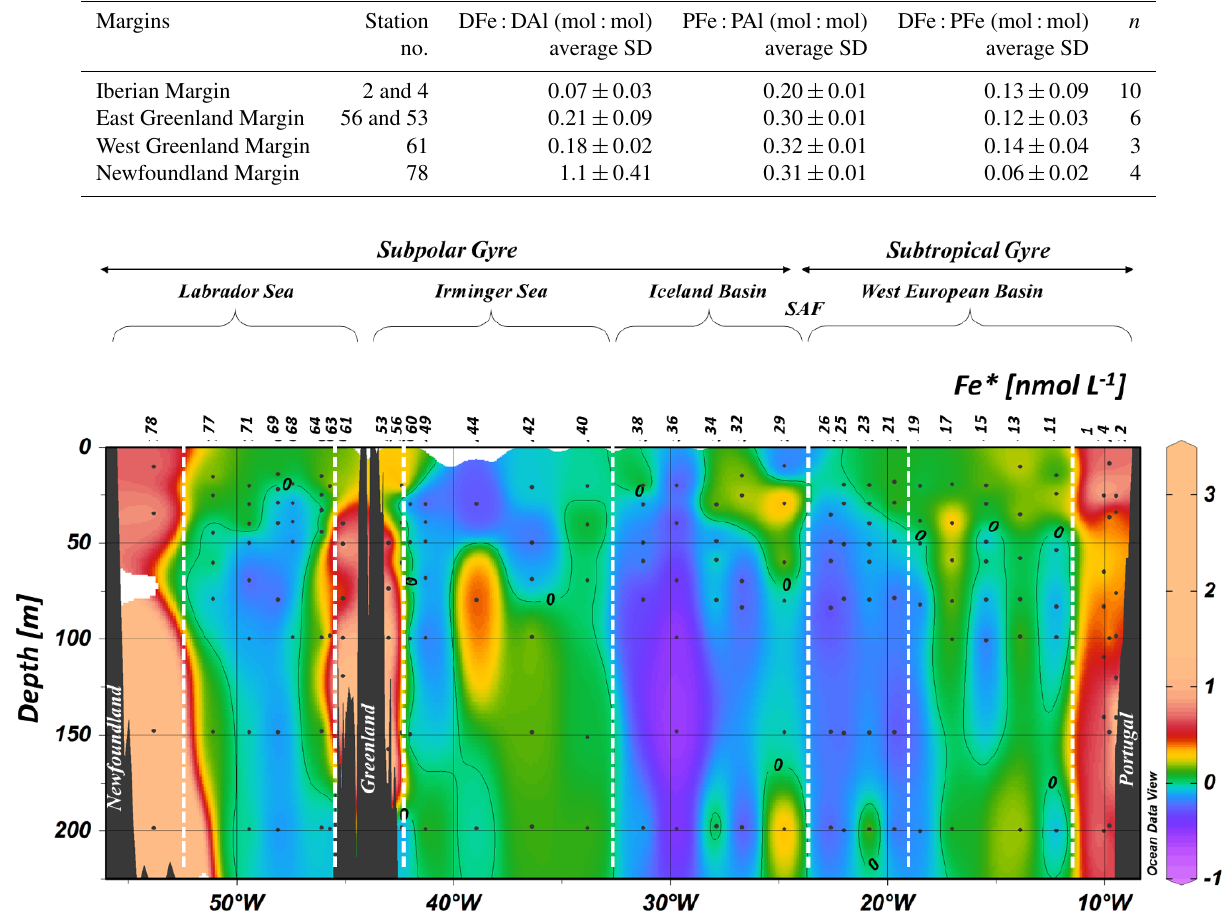
Figure 7. Section plot of the Fe ∗ tracer in the North Atlantic Ocean with a remineralization rate ( R Fe : N ) of 0.05mmolmol − 1 from surface to 225m depth. A contour line of 0 separates areas of negative Fe ∗ from areas with positive Fe ∗ . Positive values of Fe ∗ imply there is enough iron to support complete consumption of NO − when this water is brought to surface, and negative Fe ∗ values imply a deficit. See text for 3